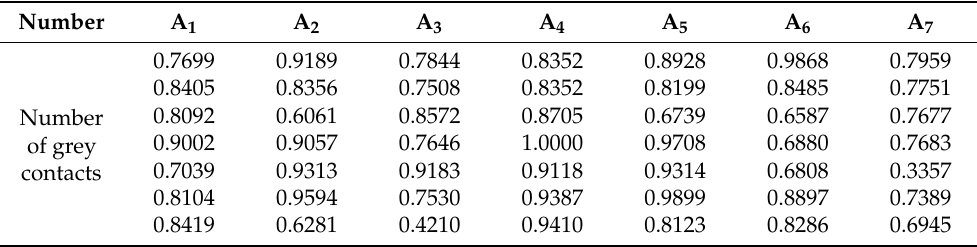
Table 5. Gray correlation coefficients of surface subsidence influencing factors and surface subsidence coefficients in Lu’an mining area.